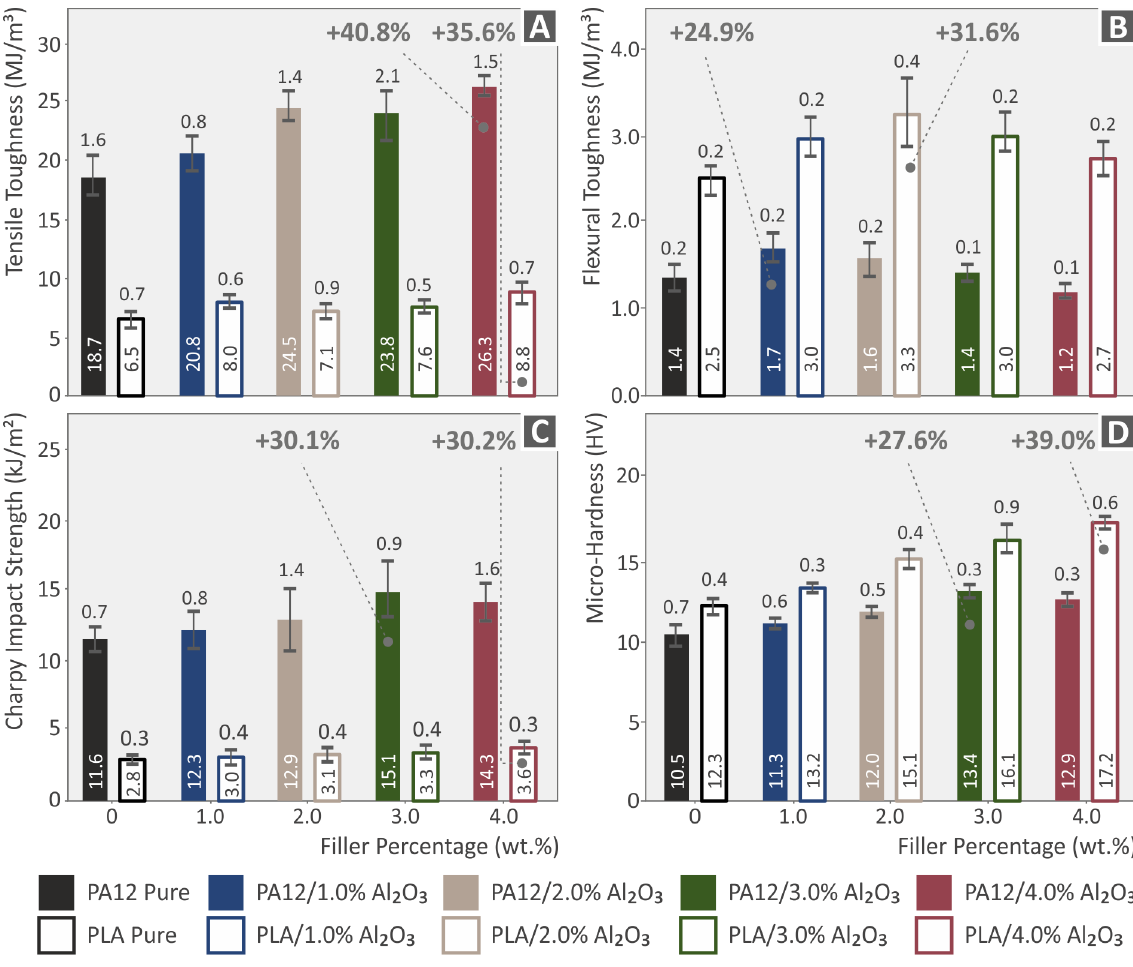
Figure 17. Tensile toughness ( A ), Flexural toughness ( B ), Charpy’s notched impact strength (kJ/m 2 ) ( C ), and Micro-hardness (Vickers (HV)) ( D ) properties of neat PA12 and PLA, as well as of their respective nanocomposites at 1.0, 2.0, 3.0, and 4.0 wt.% of Al 2 O 3 filler loading. Legend shows which color corresponds to which material in each graph.